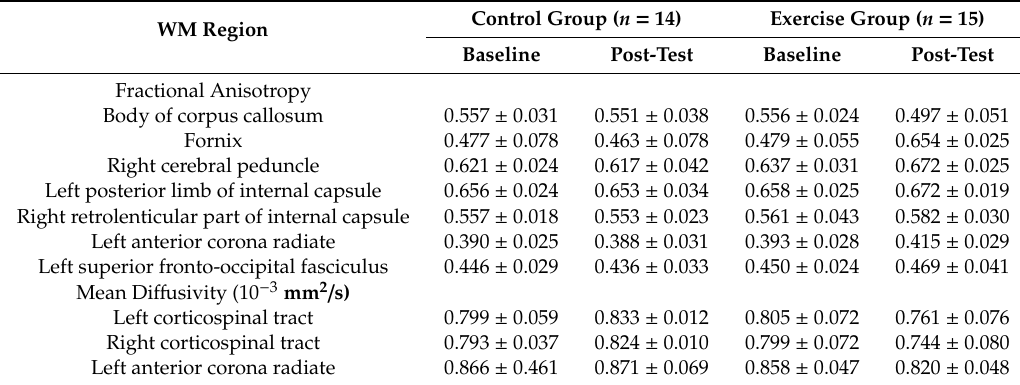
Table 5. Di ff erences in FA and MD values for specific fiber tracts in an atlas-based ROI analysis between groups (mean ± standard deviation).